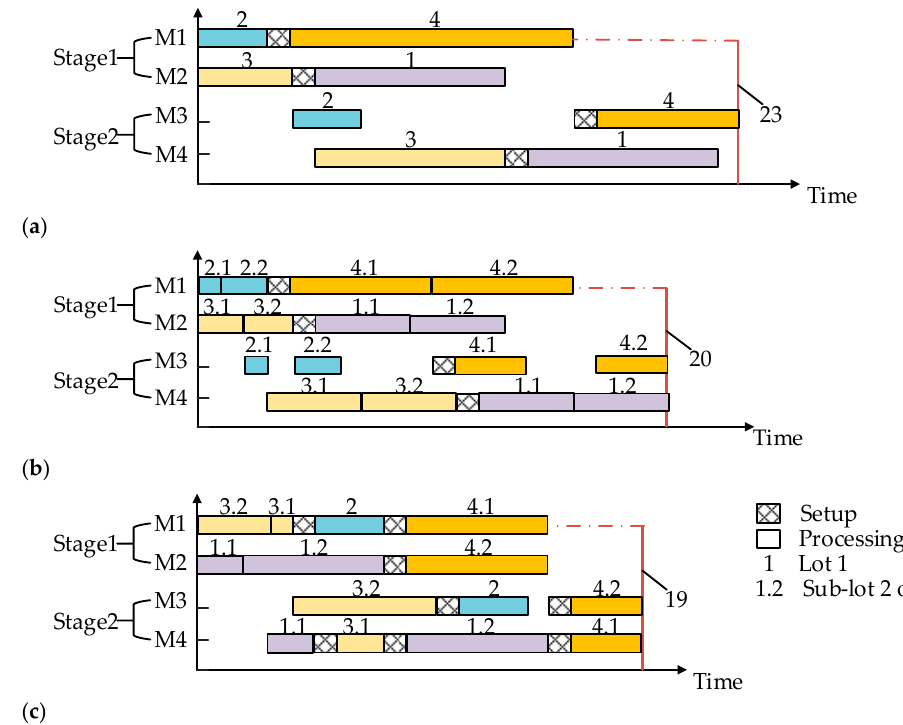
Figure 1. Lot-streaming HFSP with/without intermingling. ( a ) HFSP without lot-streaming; ( b ) Lot- streaming HFSP without intermingling; ( c ) Lot-streaming HFSP with intermingling.